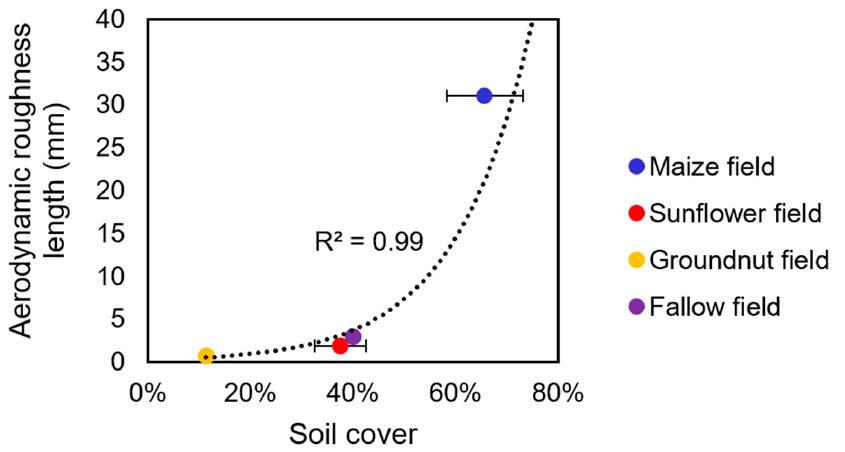
Figure 8. The soil cover versus the aerodynamic roughness length from the monitored fields. The maize field and the sunflower field showed a spatial distribution of the soil cover, which was determined by the planting, crust and track rows. The planting rows had a much higher soil cover (85 and 48% for the maize field and sunflower field, respectively), than that on the track and crusted rows (38% and 24% on average, respective). This difference in soil cover raises the question of whether the highest, lowest, or average soil cover controls the erosion on a field within a typical pattern of surface